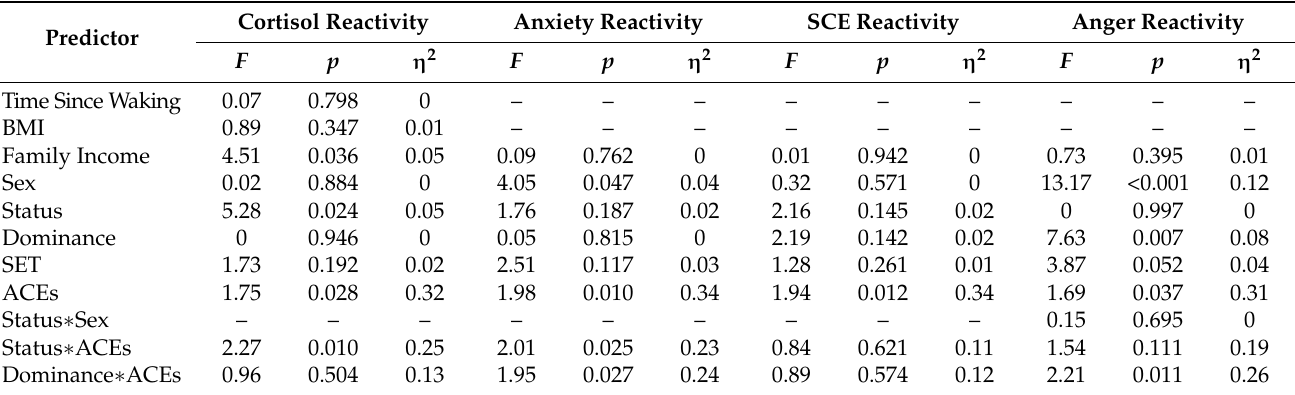
Table 2. Results of Multivariate Analyses Examining the Associations Between Early Adverse Experiences and Study Manipulations on Changes in Salivary Cortisol and Negative